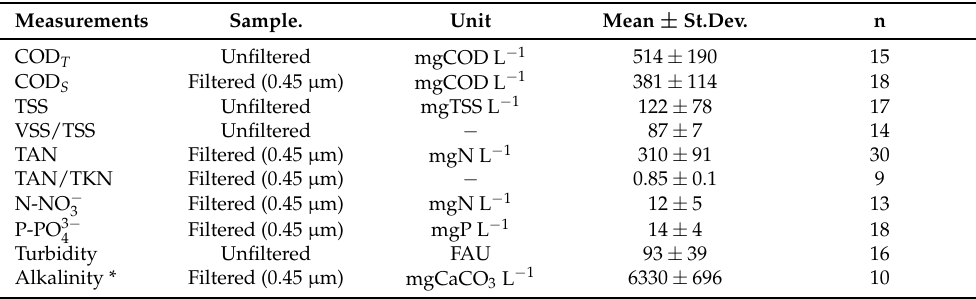
Table A2. Average influent characteristics and number of experimental samples (n). (*): The alkalinity measurements were done on the undiluted centrate, while all the other measurements reported in this table were executed on the diluted